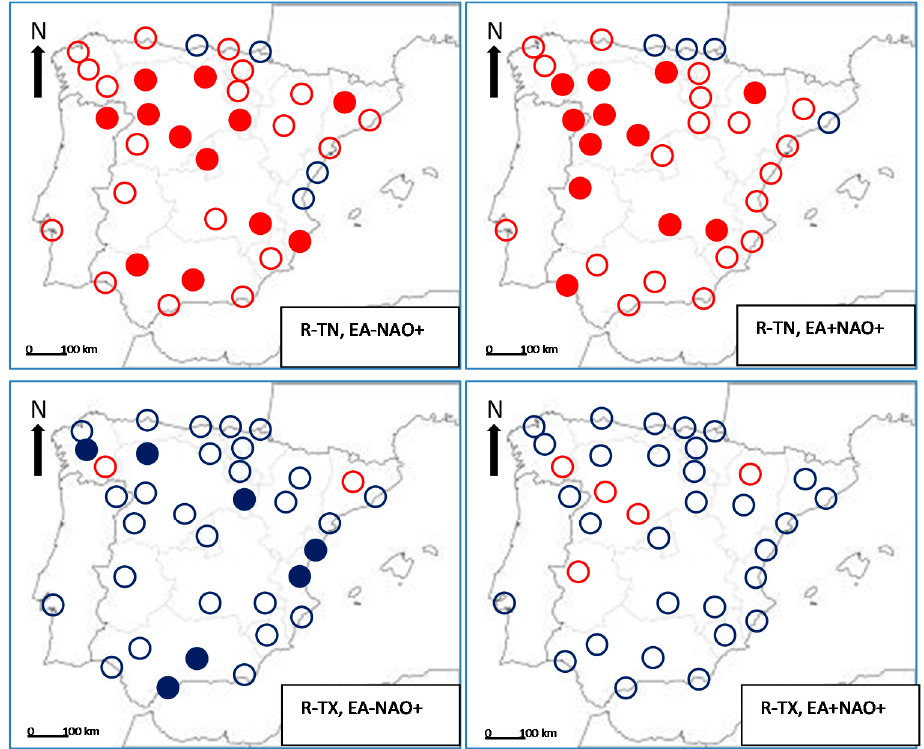
Figure 8. Correlation coefficients between TN, TX and R under EA-NAO+ and EA+NAO+ composites for winter. Red: positive; Blue: negative; Full (empty): significant (non-significant) at the 95% confidence level.